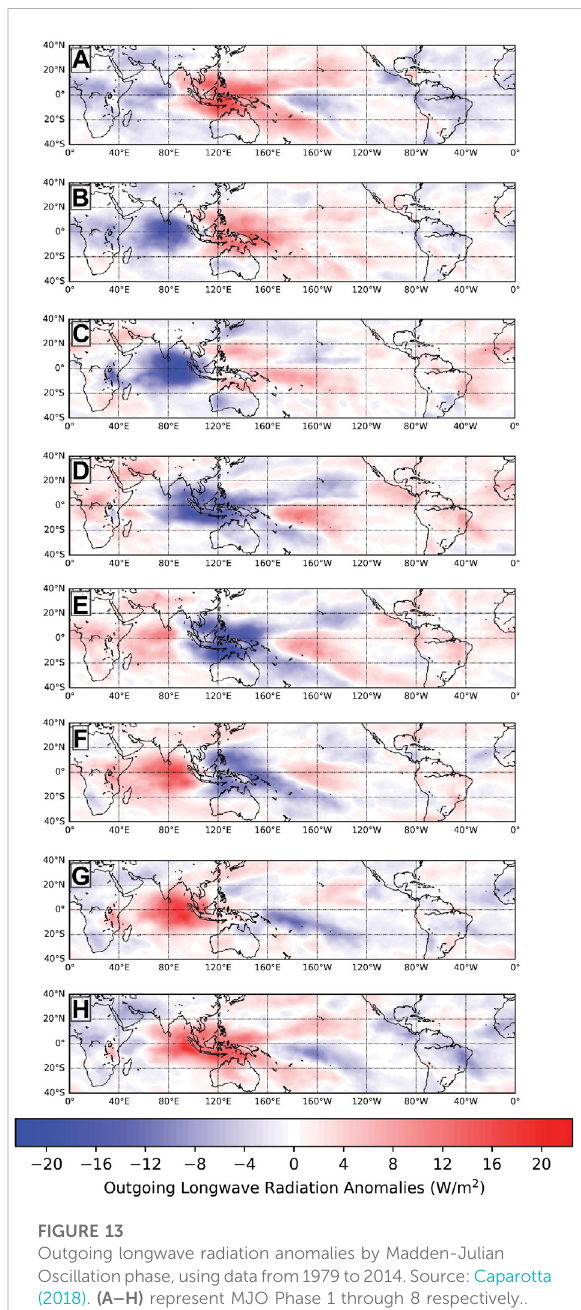
FIGURE 13 Outgoing longwave radiation anomalies by Madden-Julian Oscillationphase,usingdatafrom1979to2014.Source:Caparotta (2018). (A – H) represent MJO Phase 1 through 8